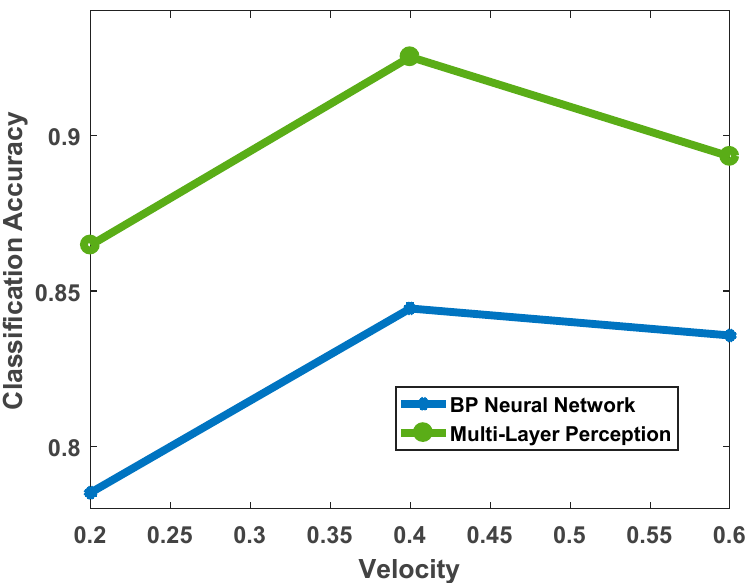
Figure 11. Classification accuracy of two algorithms at different speeds.